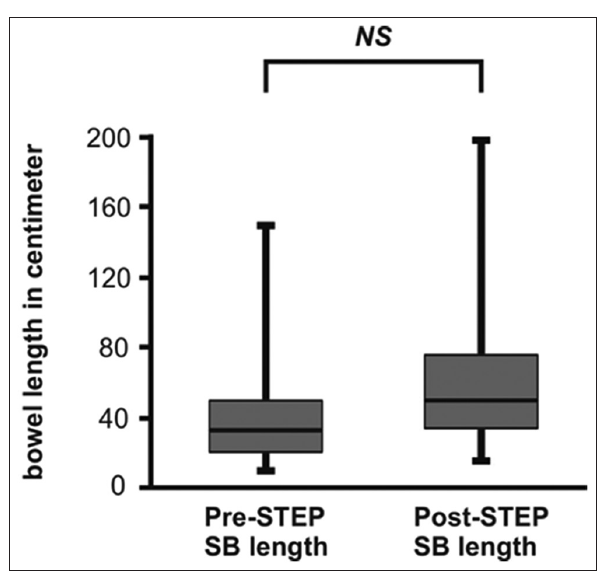
Figure 3: Pre-post small bowel length comparison of “first